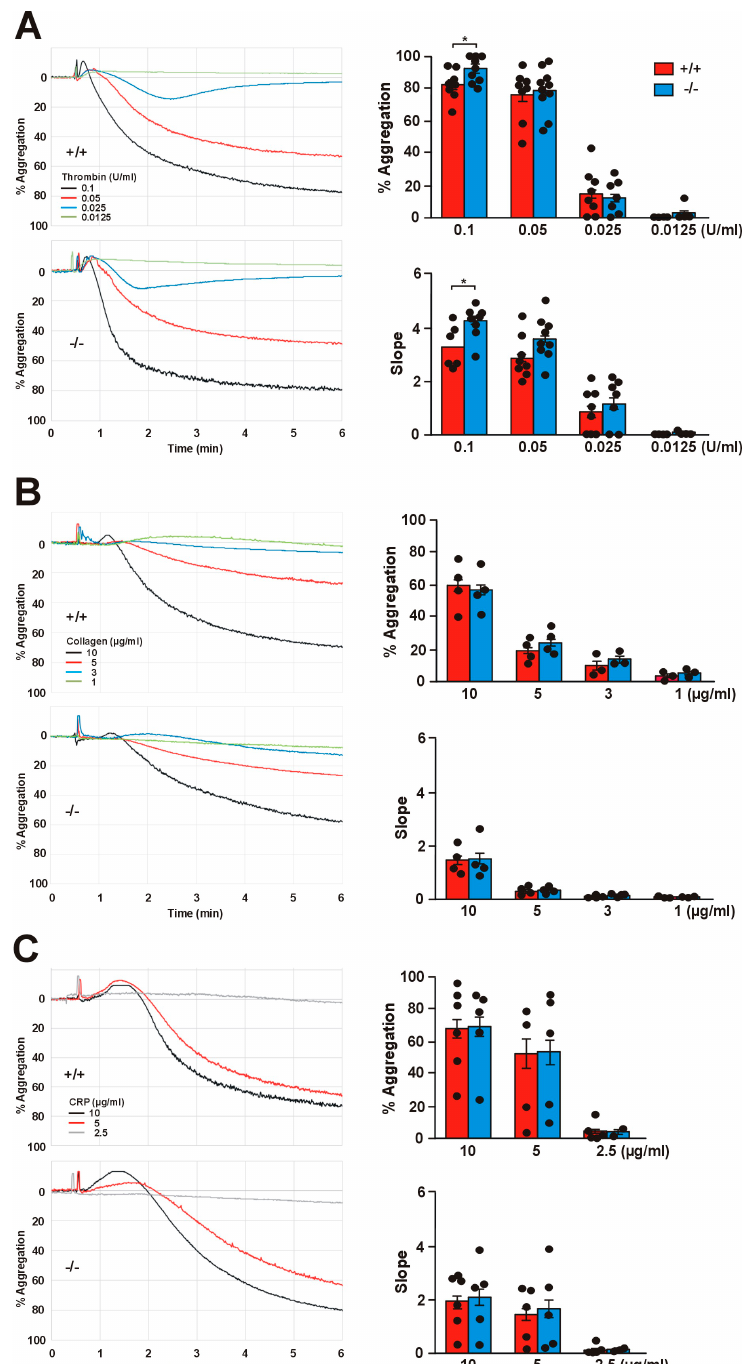
Figure 4. Aggregation in Coro1a deficient platelets. Washed platelets (2.0 × 10 8 platelets/mL) were stimulated with the indicated doses of thrombin ( A ), collagen ( B ), or collagen-related peptide (CRP) ( C ) and aggregation was recorded for 6 min in a Chrono-Log aggregometer. Representative traces are shown on the left. Bar diagrams show percentage of maximum aggregation within 5 min of stimulation and slope as calculated from the linear part of the aggregation trace. Data are mean ± SEM of 4–10 independent experiments. * p < 0.05, Student’s t -test for thrombin; no significant differences were found with collagen and CRP, Mann–Whitney U-test.